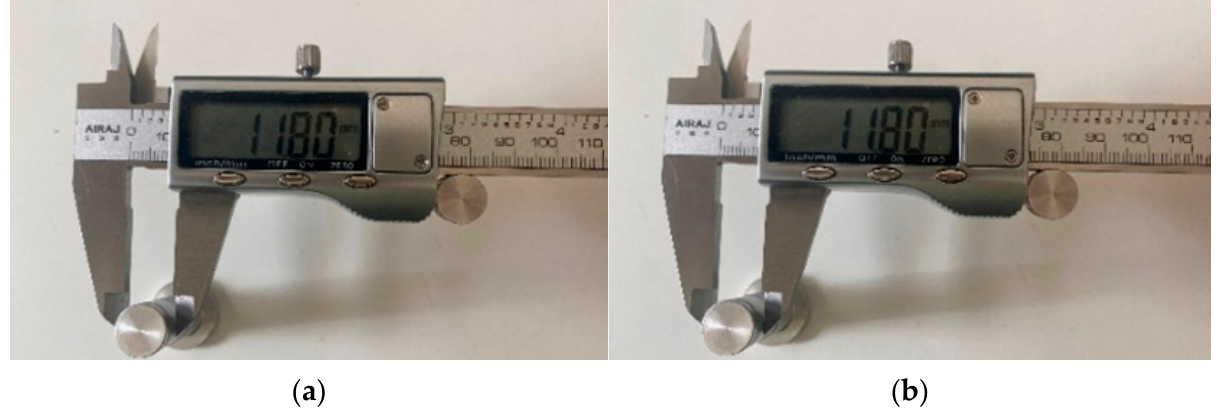
Figure 15. Shaft with clearance (clearance value = 0.1 mm). ( a ) Shaft A. ( b ) Shaft B. Table 4. Geometric and inertial parameters of the test platform.